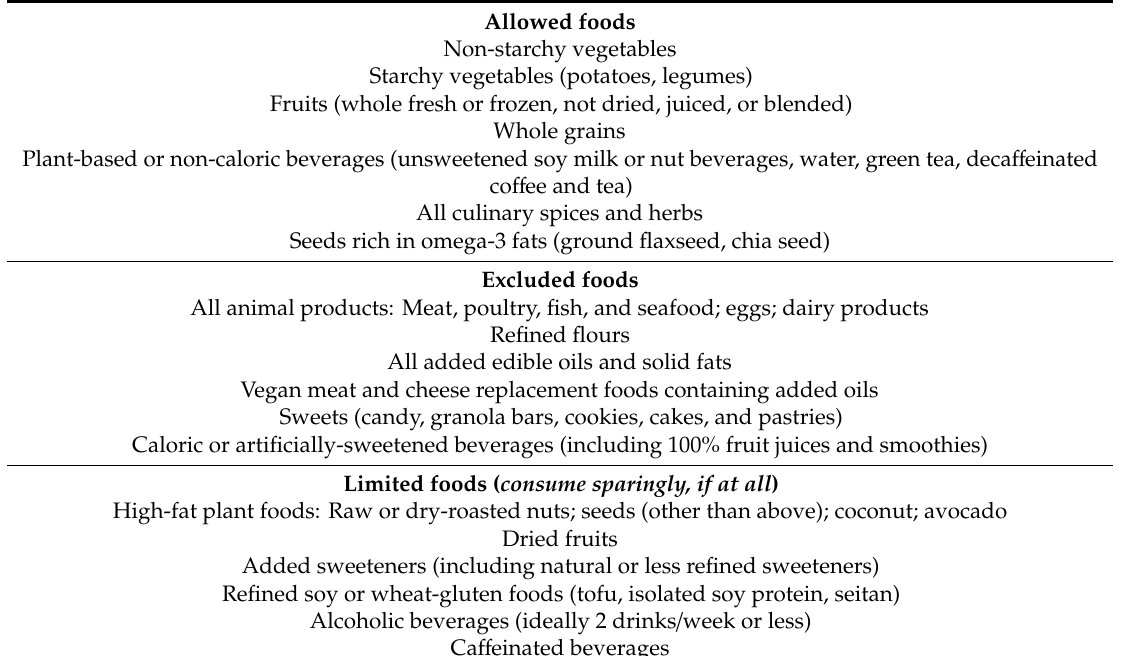
Table 1. Ad libitum whole-food plant-based